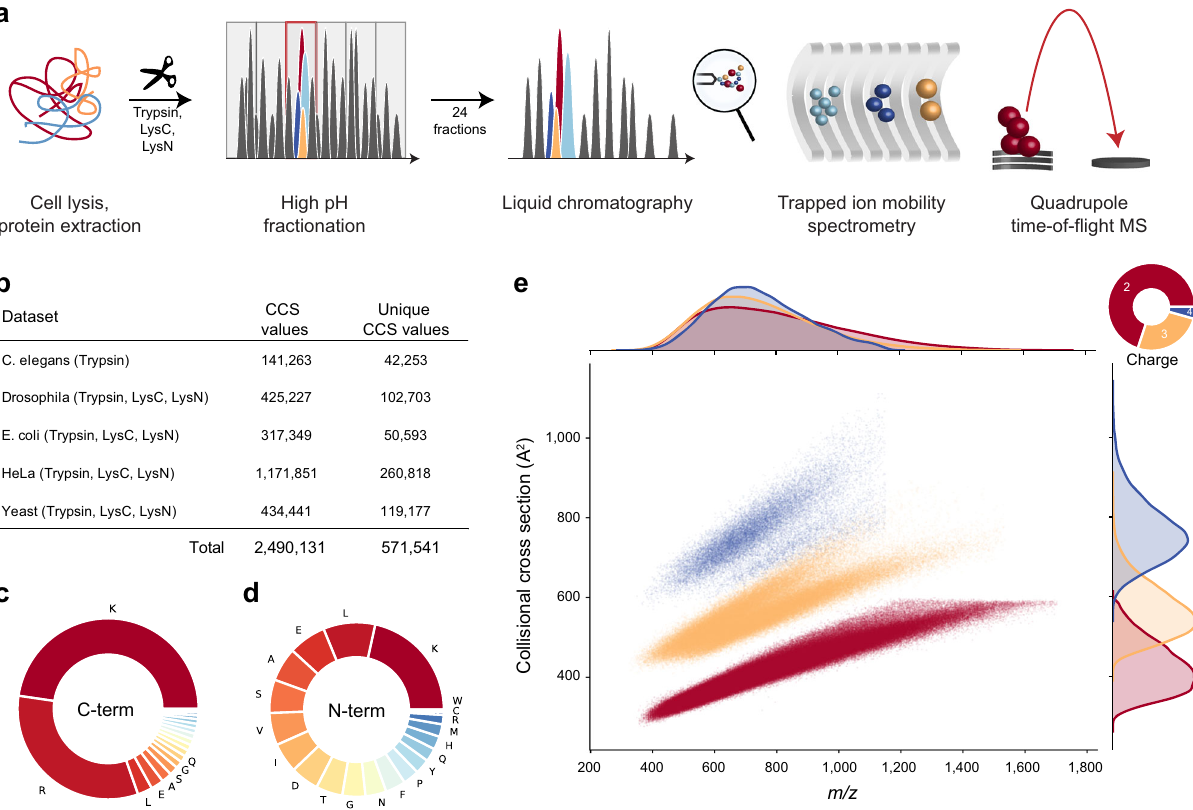
Fig. 1 Large-scale peptide collisional cross section (CCS) measurement with TIMS and PASEF. a Work fl ow from extraction of whole-cell proteomes through digestion, fractionation, and chromatographic separation of each fraction. The TIMS-quadrupole TOF mass spectrometer was operated in PASEF mode. b Overview of the CCS dataset in this study by organism. c Frequency of peptide C-terminal amino acids. d Frequency of peptide N-terminal amino acids. e Distribution of 559,979 unique data points, including modi fi ed sequence and charge state, in the CCS vs. m/z space color-coded by charge state. Density distributions for m/z and CCS are projected on the top and right axes, respectively. Source data are provided as a Source Data fi